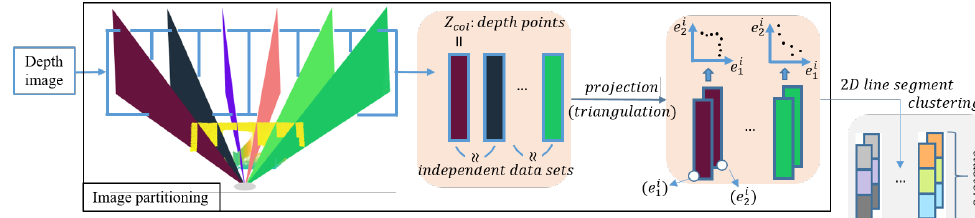
Figure 6. Depth image points practically lie on color coded planes sections, which means that the lines can be detected in 2D